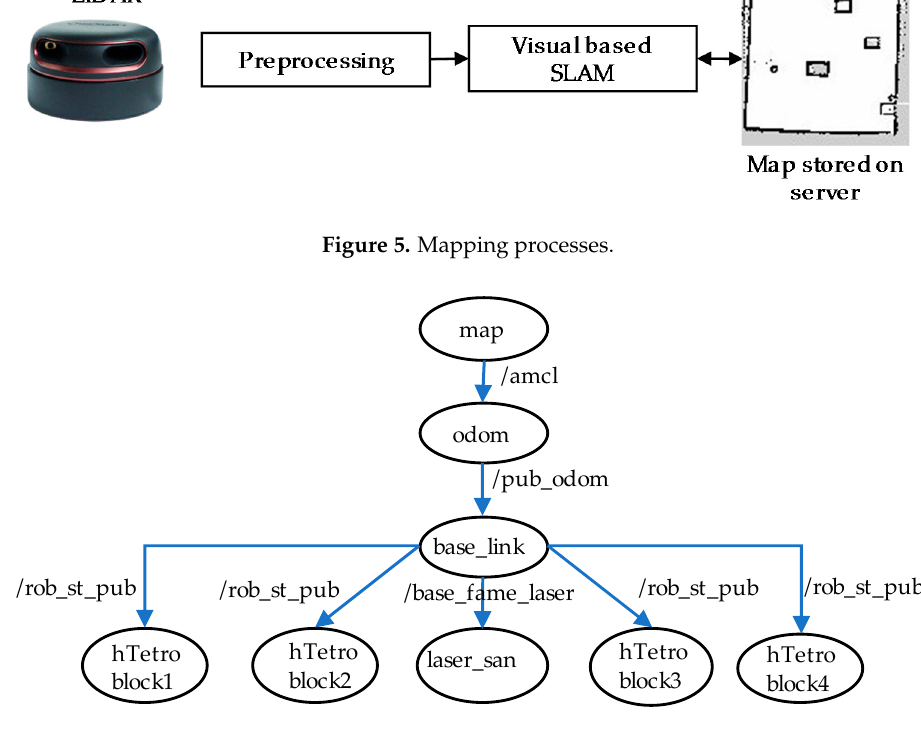
Figure 6. Transformation frame (TF) transformation tree.